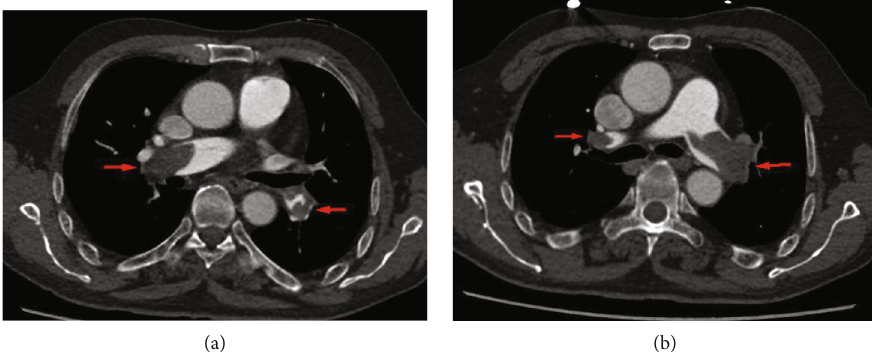
Figure 3: Computed tomography angiography (CTA) showed pulmonary embolism (yellow arrow) in the second patient (a, b).